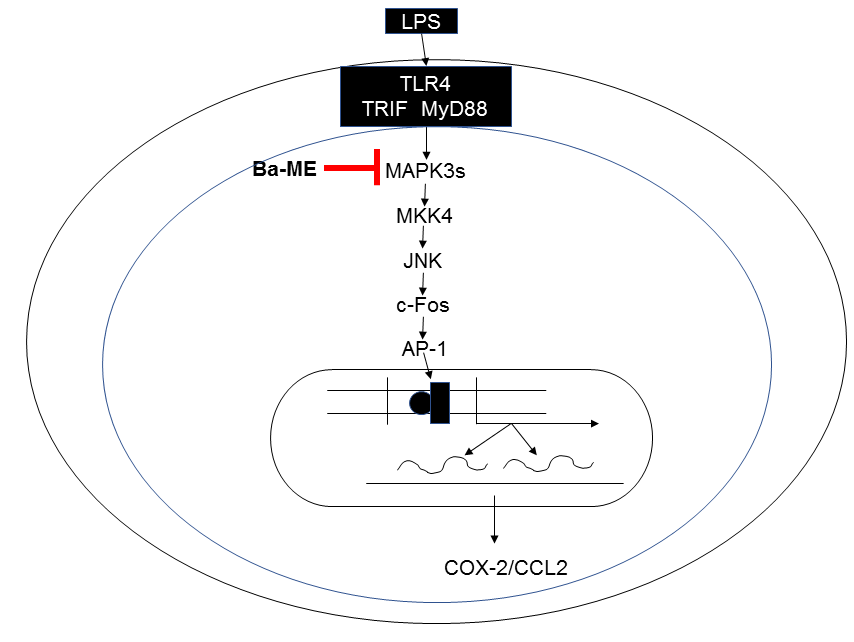
Figure 6. Signaling pathway scheme of Ba-ME’s anti-inflammatory action.